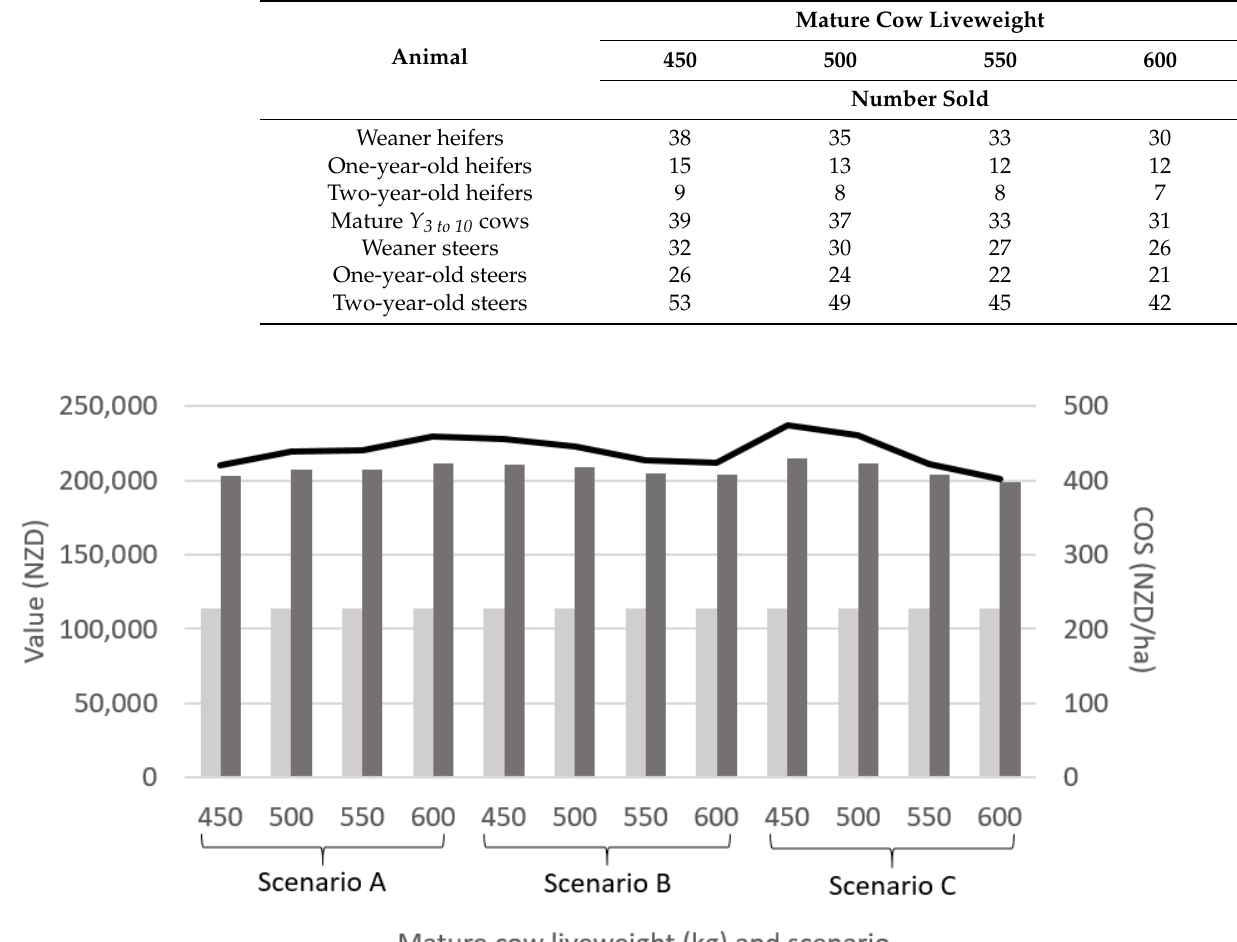
Table 6. Numbers of cattle sold of each sex and age with varying mature cow liveweight. Values are for scenario A as numbers did not differ by more than three for each group of equivalent cattle between scenarios A, B, and C.